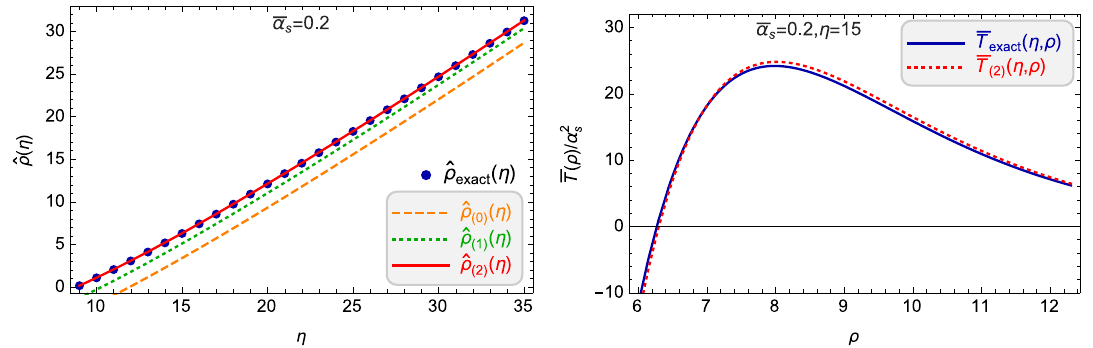
Figure 4 . Left: the growth of ^ (cid:26) ( (cid:17) ). The index in the parenthesis refers to the number of included preasympotic terms when expanding in inverse powers of (cid:17) 1 = 3 , cf. eq. (C.9). Right: the amplitude (divided by (cid:11) 2 ) as a function of (cid:26) , in the vicinity of ^ (cid:26) ( (cid:17) ) and for (cid:12)xed target rapidity (cid:17) . Numeri- s cally (denoted by exact) determined from eqs. (4.16) and (4.18) while the approximate analytical expression is given in eq.